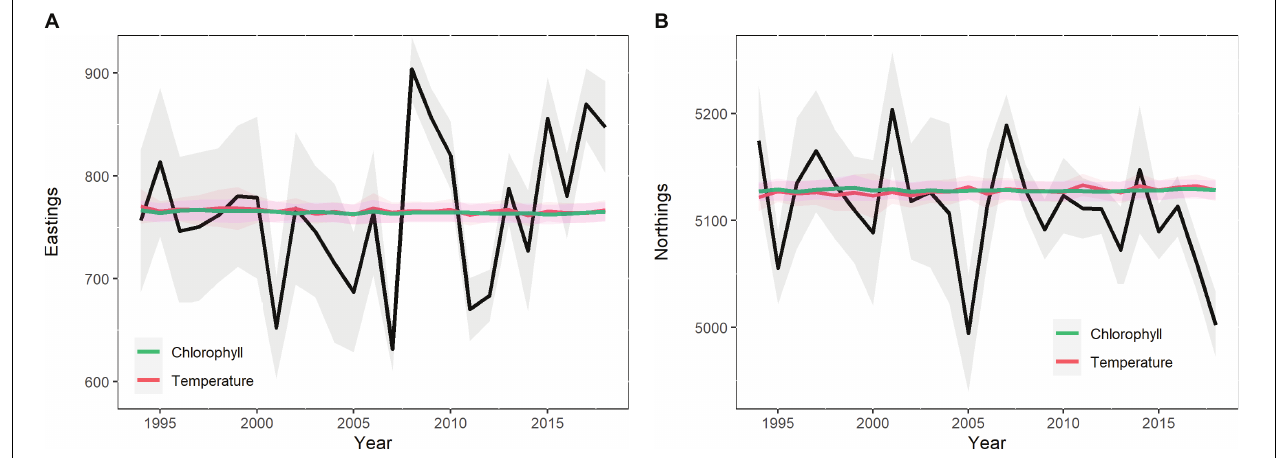
FIGURE 8 | Center of gravity estimates predicted by the baseline spatio-temporal model (black line) and by the temperature and chlorophyll-based models (with no random effects, colored line), expressed in easting (A) and northings (B)